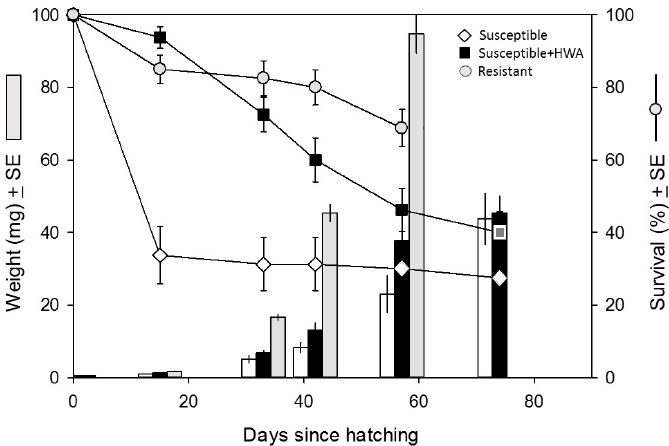
Figure 1. Mean ± SE weight (bars, left y-axis) and survival (circles, right y-axis) of larvae fed one of three different Tsuga foliage types. Data were collected in each treatment until pupation began. Susceptible = white diamonds/bars; Susceptible + HWA = black squares/bars; Resistant = gray circles/bars. N = 16 for each sampling point. Larvae on Resistant foliage pupated by day 57; larvae on Susceptible + HWA and Susceptible foliage by day 74.